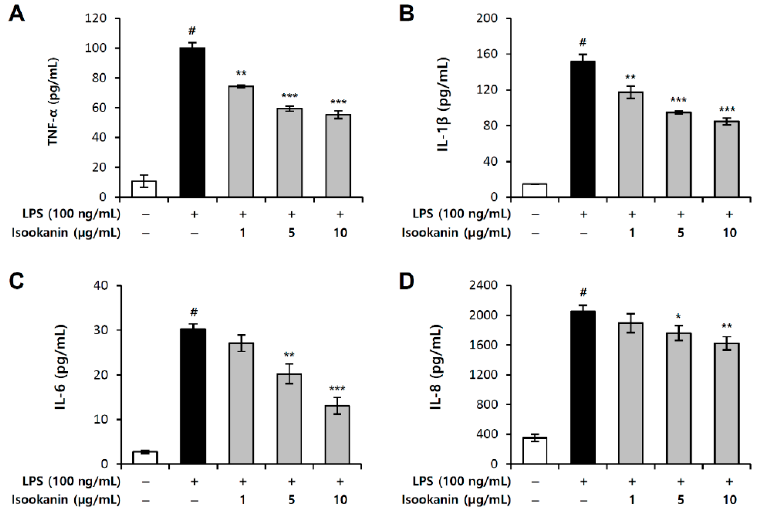
Figure 7. Inhibitory effect of isookanin on LPS-induced tumor necrosis factor-a (TNF- α ), interleukin-6 (IL-6), interleukin-8 (IL-8), and interleukin-1 β (IL-1 β ) production in THP-1 cells. Cells were pretreated with the indicated concentrations of isookanin for 2 h, before incubation with LPS (5 ng/mL) for 24 h. The levels of ( A ) TNF- α , ( B ) IL-1 β , ( C ) IL-6, and ( D ) IL-8 in the culture medium were measured by an ELISA kit. The results are mean ± standard deviation (SD) ( n = 3). # p < 0.01 vs. LPS- untreated control. * p < 0.05, ** p < 0.01, and *** p < 0.001 vs. LPS-treated control.